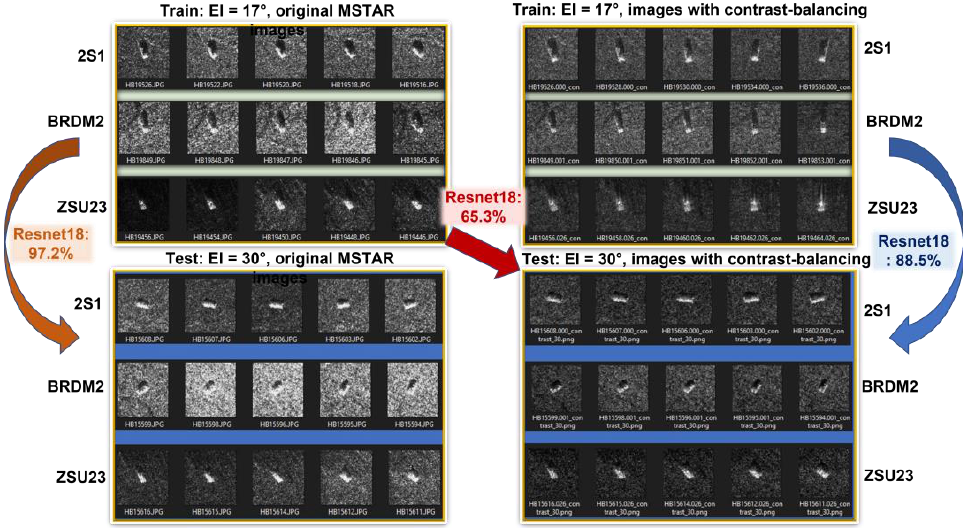
Figure 1. Clutter backgrounds have a great effect on target classification